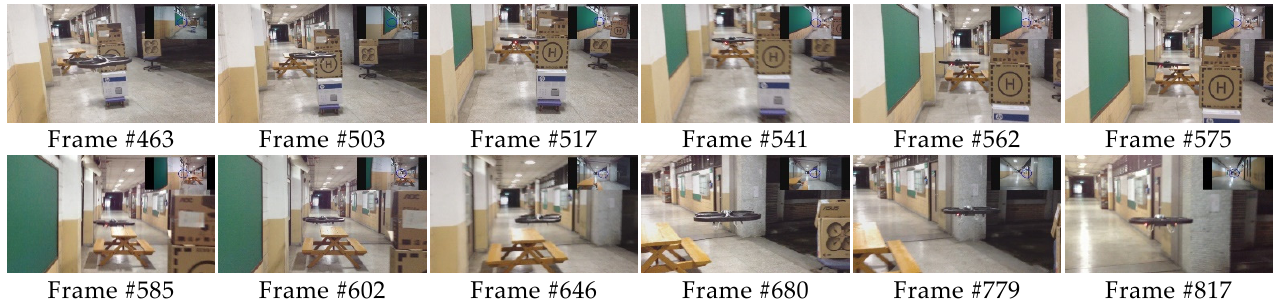
Figure 11. Obstacle avoidance of the MUAV corresponding to Figure 10. The images are recorded from a third camera.